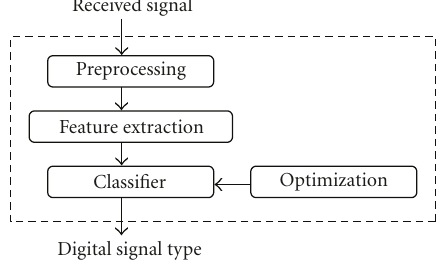
Figure 1: General scheme of the proposed identifier.